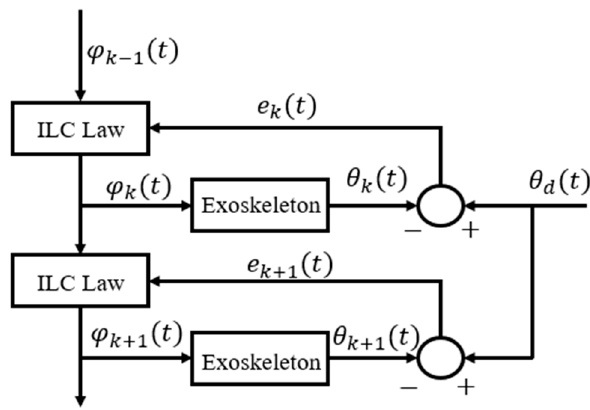
Figure 1. The block diagram of the iterative learning control (ILC) algorithm.